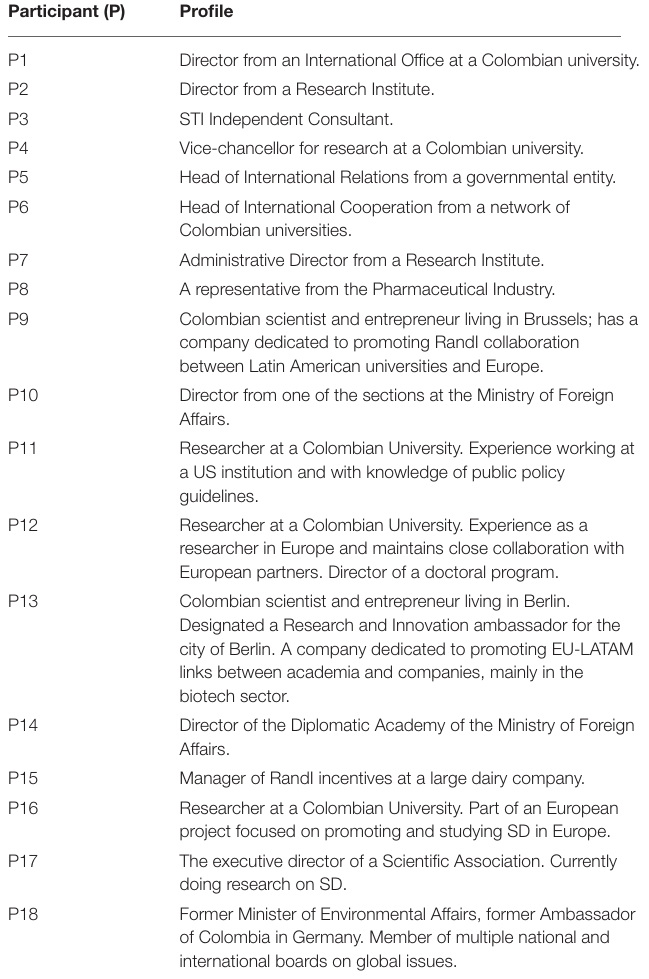
TABLE A1 | Research participants and